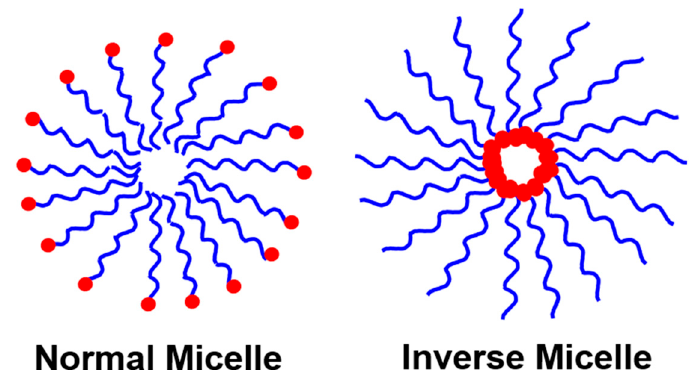
Figure 1. Schematic representation of normal and inverse micelles.